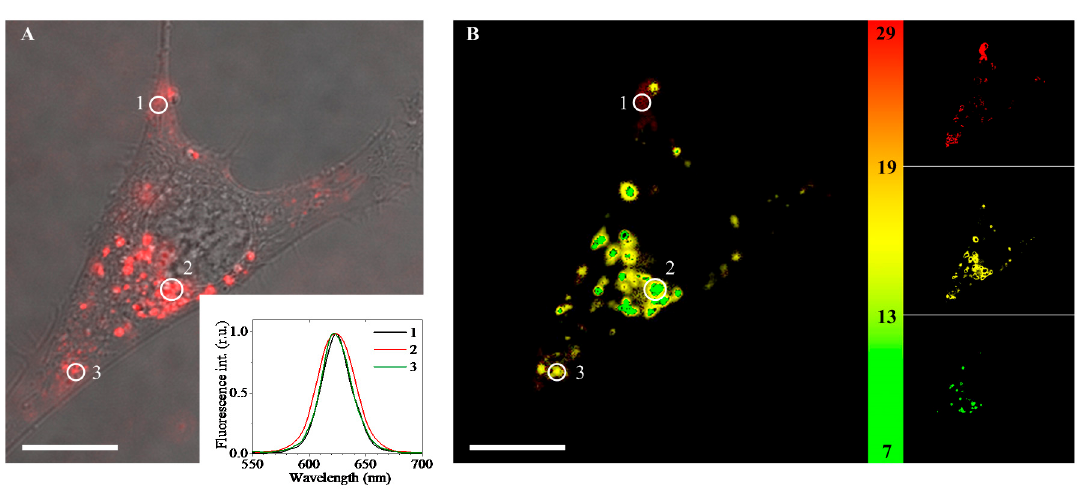
Figure 1. Microscopy images of immortalized mouse embryonic fibroblast (NIH3T3) cells incubated with quantum dots (QDs) for 3 h: ( A ) overlaid phase contrast and confocal fluorescence images, an inset—normalized fluorescence spectra of the cell’s areas marked with 1, 2 and 3 white circles; and ( B ) overlaid fluorescence-lifetime images in different lifetime decay gates (7–13 ns—green, 13–19 ns—yellow and 19–29 ns—red); right panel shows fluorescence-lifetime imaging (FLIM) images in green, yellow and red gates separately. Scale bar: 5 μ m.